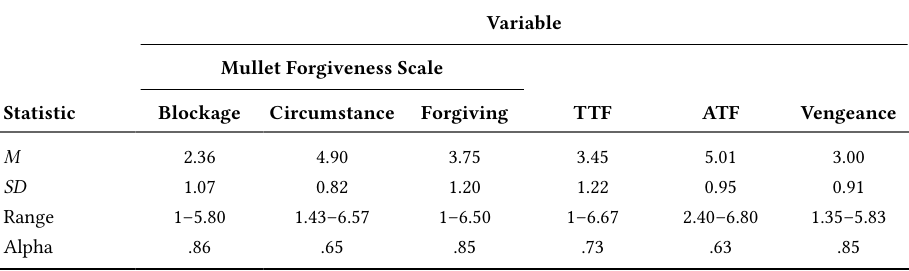
Descriptive Statistics and Reliabilities: Tendencies to Forgive, Seek Revenge, and View Forgiving as Desirable